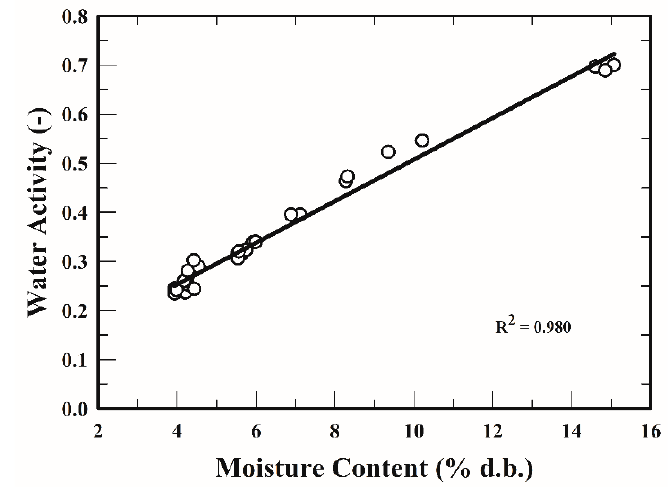
Figure 4. Profiles of the water activity of wheat germ during drying in the FBD at different set temperatures. The symbols represent the experimental data; the solid lines represent the simulated values; the dashed line represents the target water activity of 0.3.